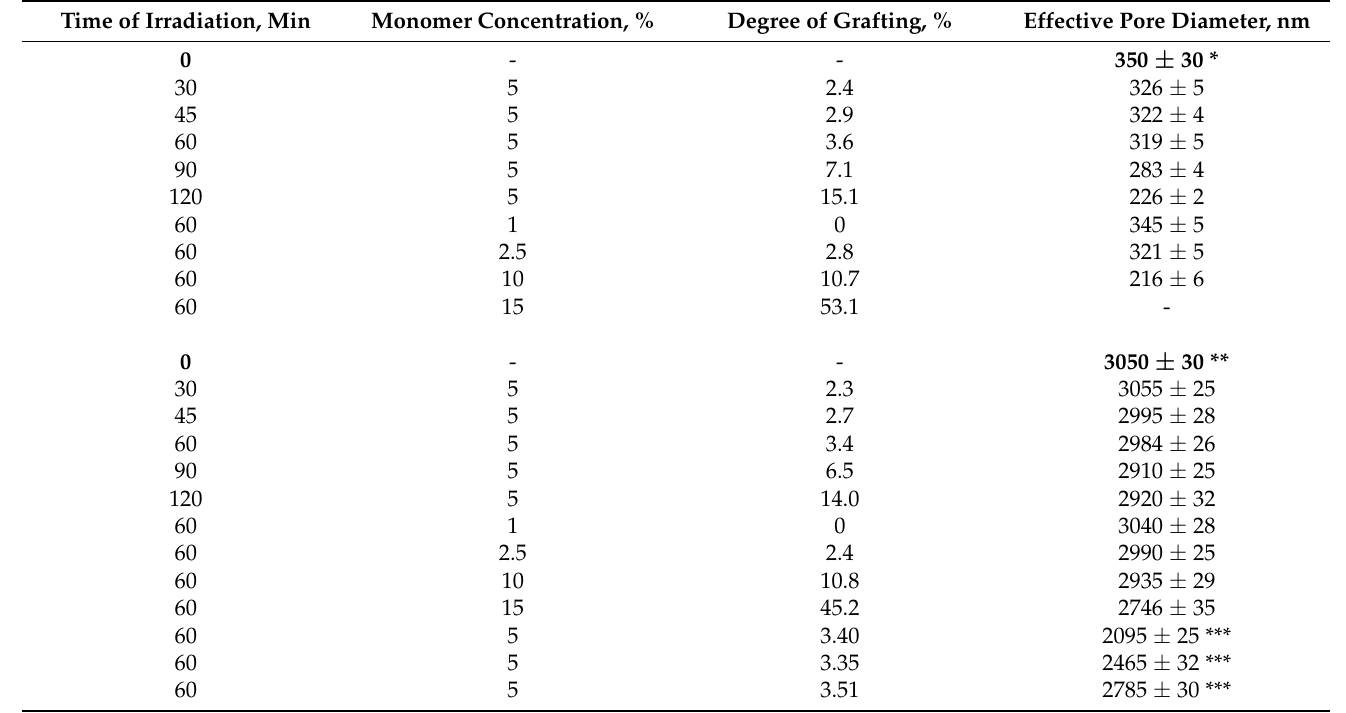
Table 1. Main parameters of PET TeMs before and after grafting with SM.